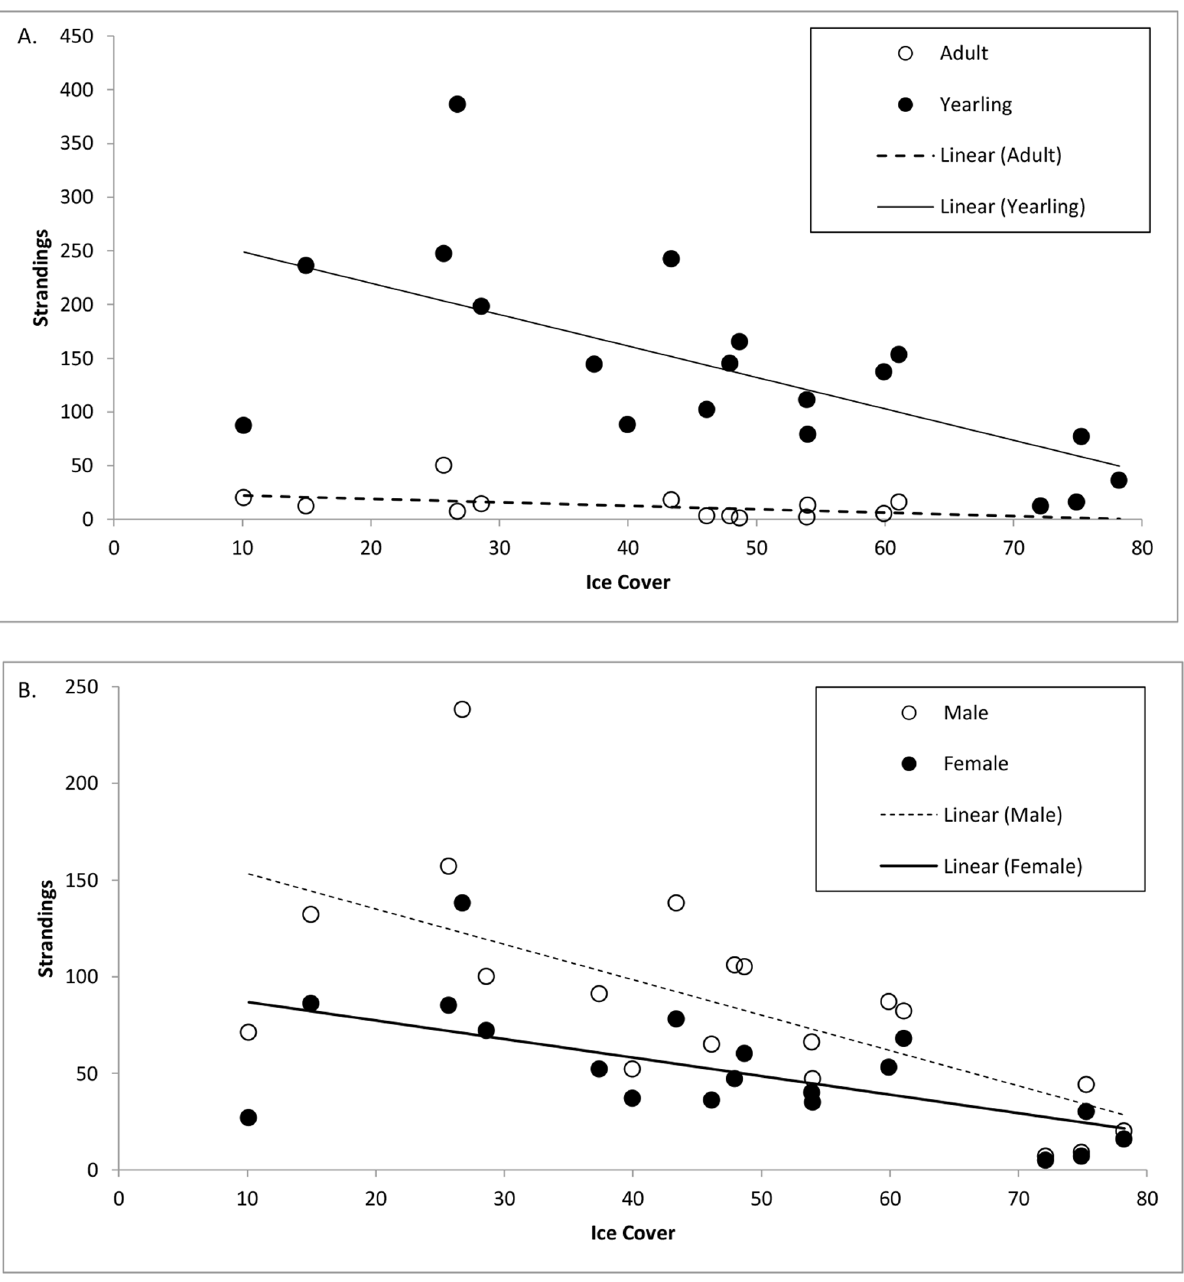
Figure 5. The relationship between percent sea ice cover and yearly strandings based on A. age class and B. sex. A. The graph represents a linear regression between percent ice cover in February and the number of yearly adult strandings (open circles and dashed line) and yearling strandings (solid dots and line). B. The graph represents a linear regression between percent ice cover in February and the number of yearly male strandings (open circles and dashed line) and female strandings (solid dots and